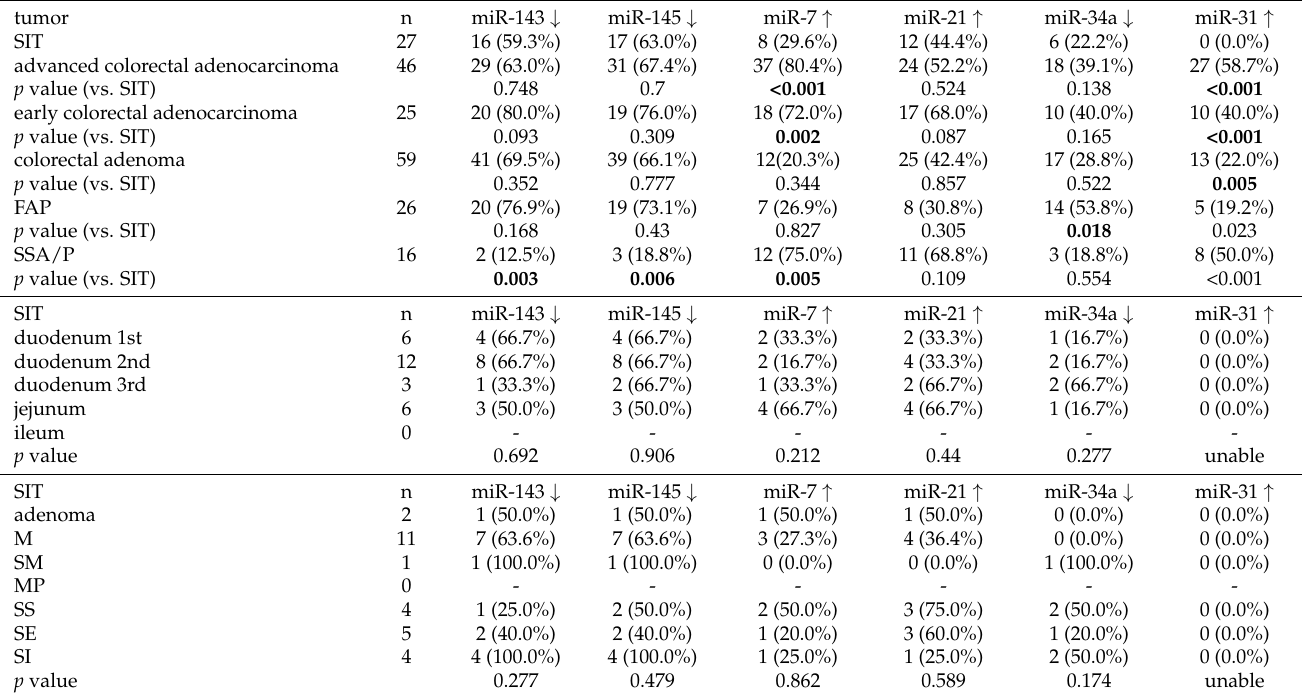
Table 1. Expressions of miRNA-143, miR-145, miR-7, miR-21, miR-34a, and miR-31 in small intestinal tumors and human colorectal tumor tissues were evaluated by performing TaqMan ® Real-time PCR